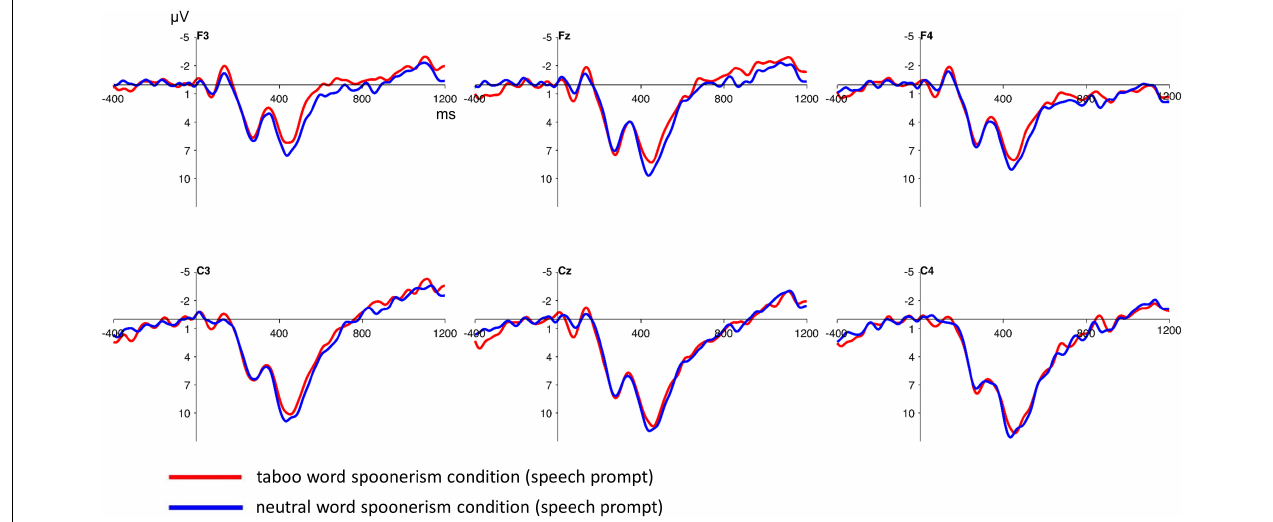
FIGURE 4 | Stimulus-locked grand average ERP waveforms at frontocentral electrodes after the presentation of the speech prompt/pronunciation cue. No significant differences between the taboo word spoonerism and the neutral word spoonerism condition are present. Baseline used is -100 to 0 ms. The displayed waveforms were filtered with a 20 Hz low-pass